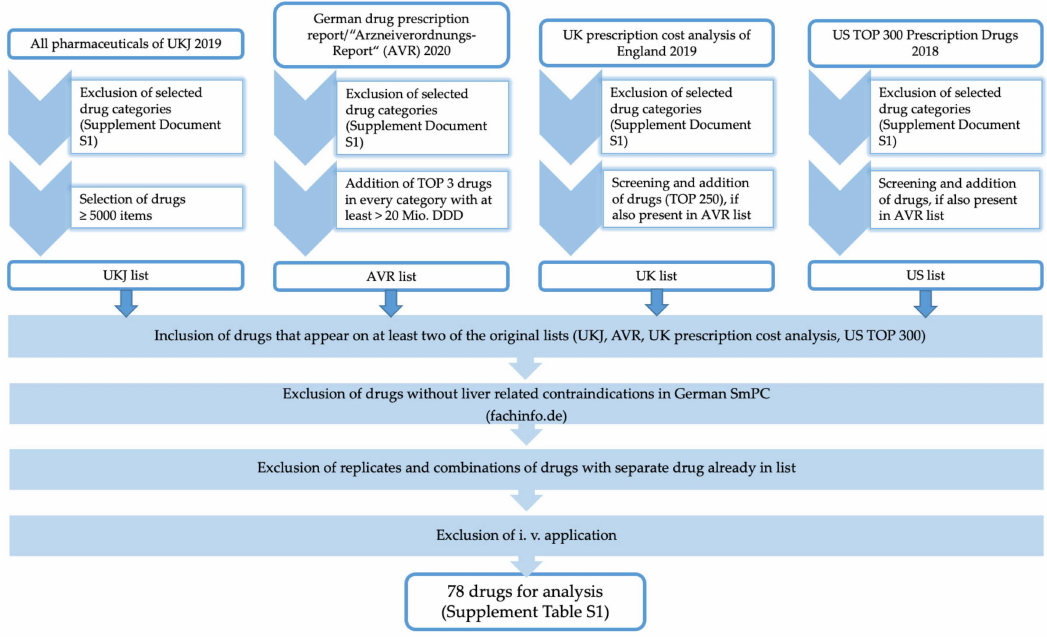
Figure 1. Selection of drugs for